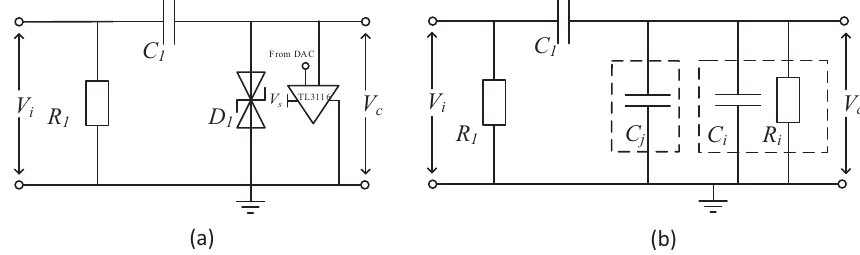
Figure 4. HPF diagram, ( a ) the actual components, ( b ) the parasitic parameters of